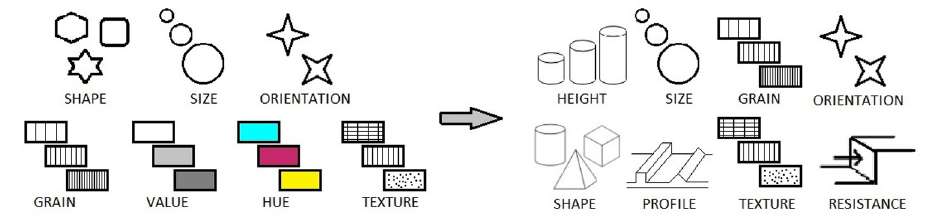
Fig 1. Graphic and haptic variables, source: Based on